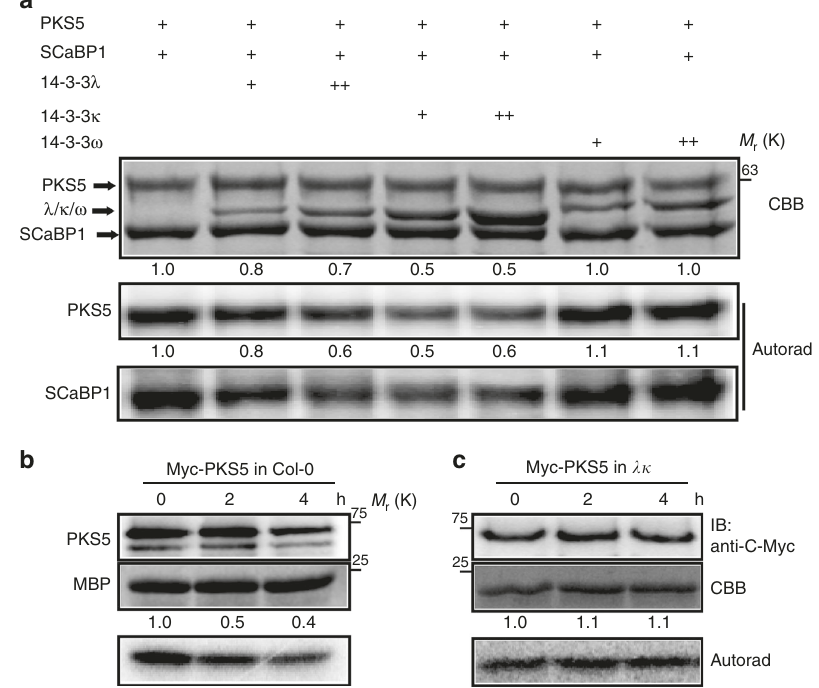
Fig. 5 14-3-3 proteins repress the kinase activity of PKS5. a In vitro kinase assay showing that 14-3-3 λ and κ proteins inhibit PKS5 activity in a dose- dependent manner. Recombinant His-tagged PKS5 was incubated with GST-tagged SCaBP1 with or without GST-tagged 14-3-3 proteins. SCaBP1 was used as the substrate and 14-3-3 ω served as a negative control. b , c Kinase assays of PKS5 in Col-0 and 14-3-3 λκ double mutant backgrounds under salt stress. Myc-PKS5 was puri fi ed from Pro35S:6×Myc-PKS5 transgenic plants treated with 100 mM NaCl for the indicated periods. MBP was used as the substrate. CBB Coomassie Brilliant Blue, Autorad autoradiograph, IB immunoblot. Source data are provided as a Source Data fi